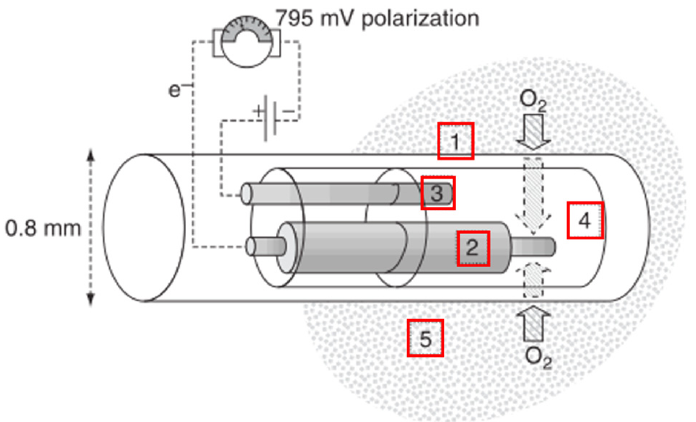
Figure 3. Schematic diagram of the electrodes in the Licox system 1. Polyethylene tube with diffuser film; 2. Gold polarographic cathode; 3. Silver polarographic anode; 4. Electrolysis chamber; 5. Target monitoring area of the brain [31].